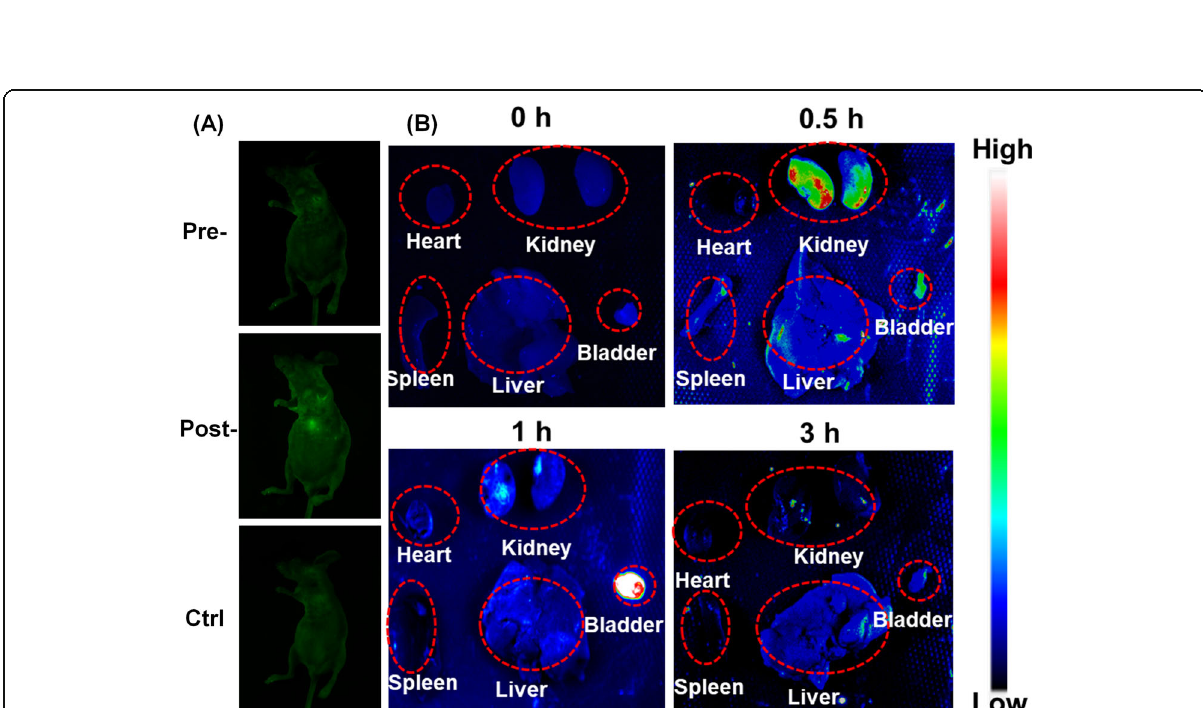
Fig. 5 In vivo animal test. a Animal fluorescent imaging with CDs. b Ex vivo imaging of the mice after intravenous injection of CDs at different time